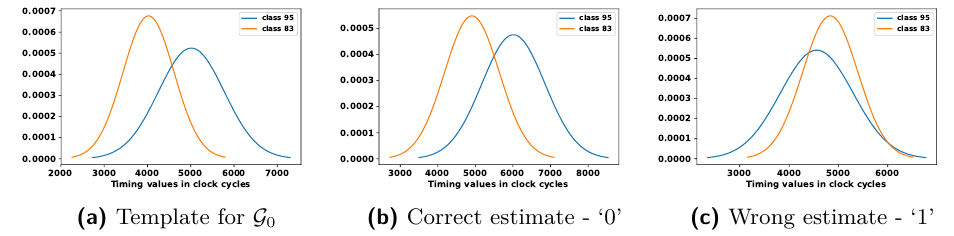
Figure 6: Template matching for bit index 350.